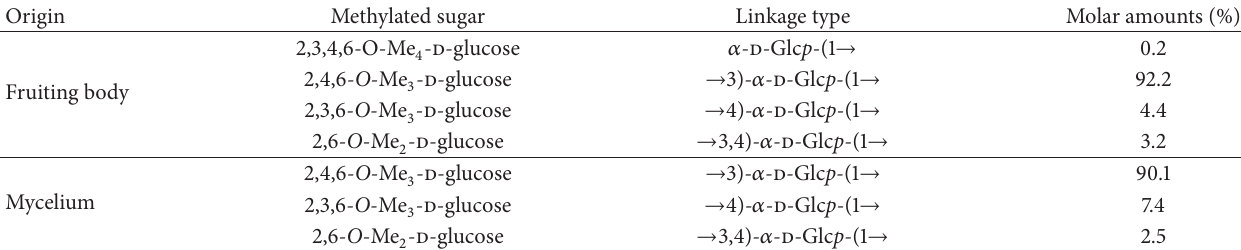
Table 3: Summary of methylation analysis of glucans extracted from fruiting body and vegetative mycelium of C. unicolor .